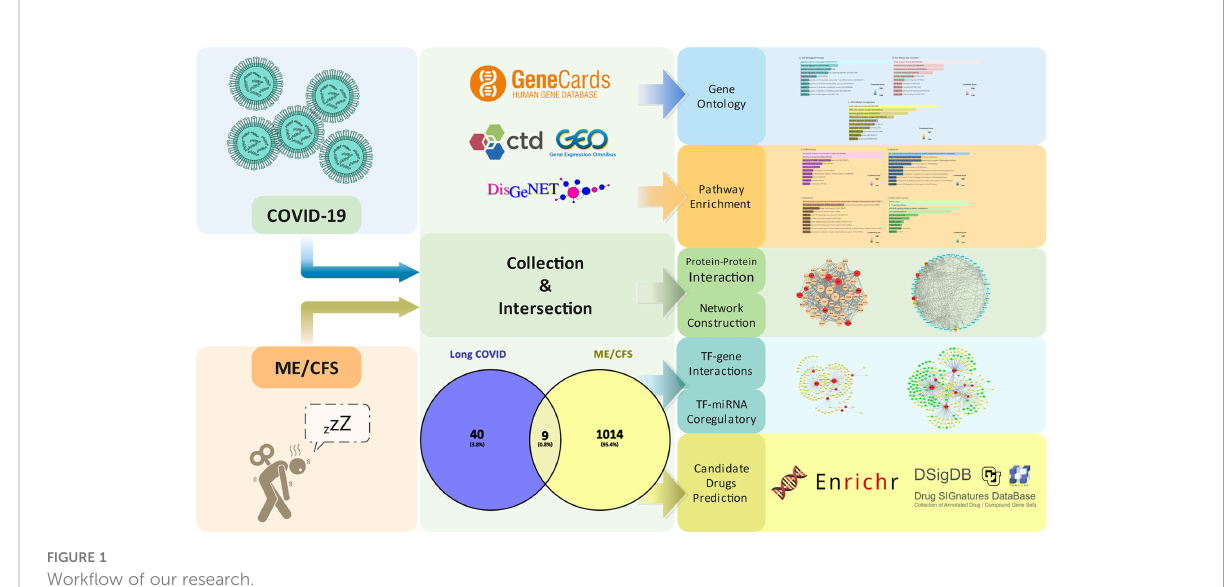
FIGURE 1 Work fl ow of our